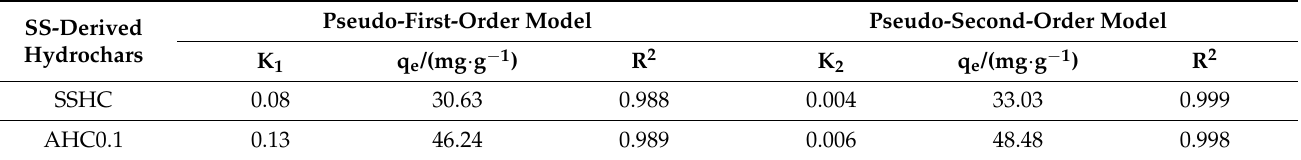
Table 6. Adsorption isotherms parameters of Pb( Ⅱ ) onto SSHC and AHC0.1.